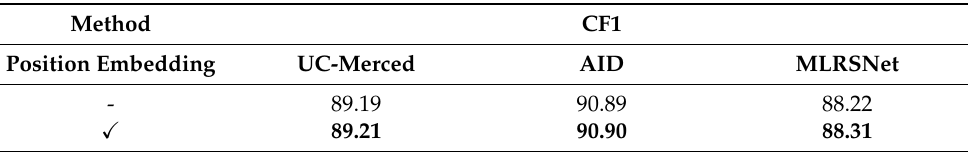
Table 6. Ablation studies on position embedding. The symbol (cid:88) represents that position embedding is in use. The bold means the best performance.